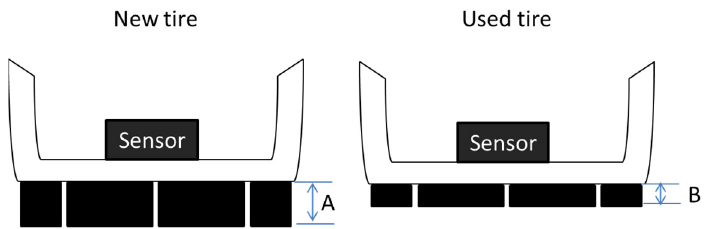
Figure 4. The difference between the new tire and the used tire.